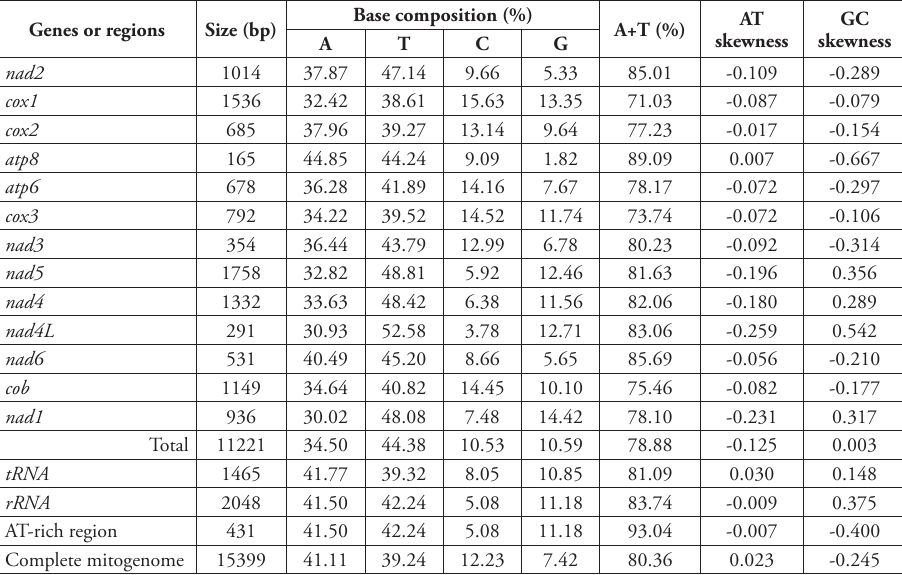
Table 2. Base composition of protein-coding, tRNA and rRNA genes, and A+T rich region of T. japonica mitogenome. Genes or